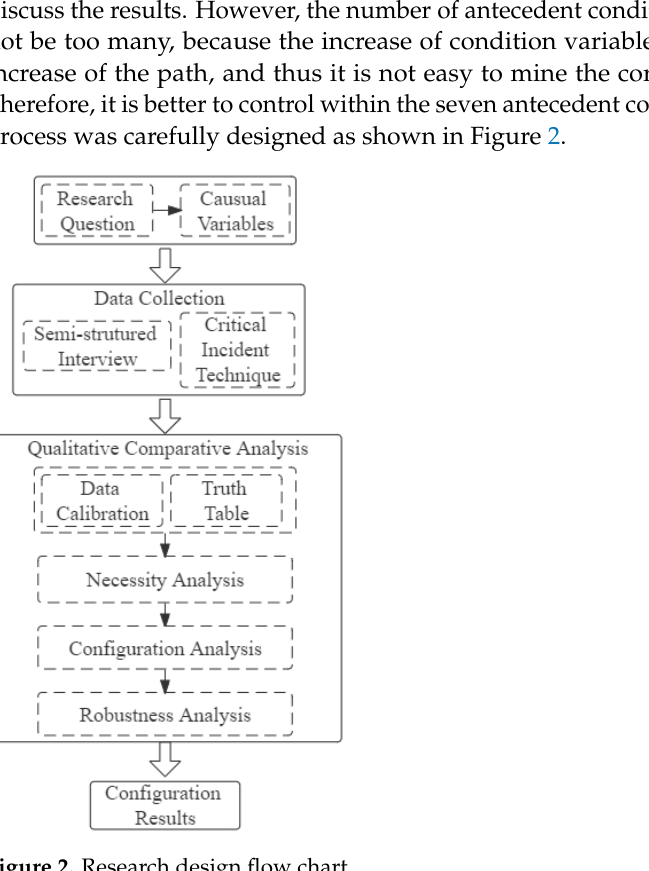
Figure 2. Research design flow chart.